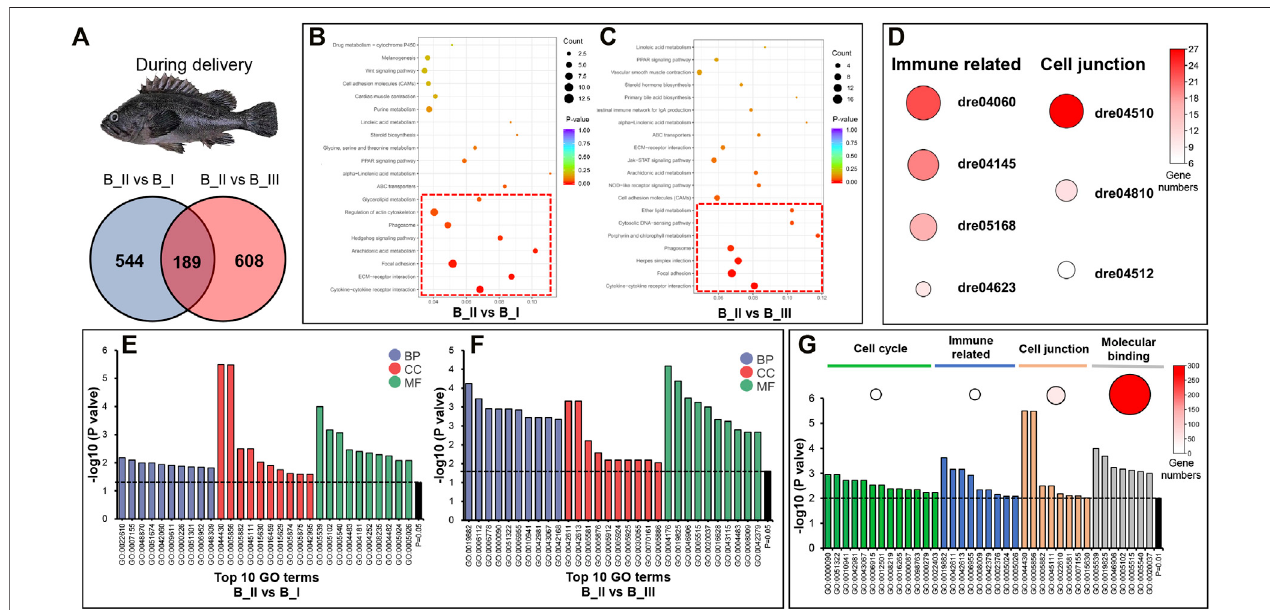
FIGURE 2 | GO and KEGG annotation of DEGs in B_II vs. B_I group and B_II vs. B_III groups. Venn diagram of DEGs in B_II vs. B_I and B_II vs. B_III (A) . Bubble chart of KEGG pathways in B_II vs. B_I (B) group and B_II vs. B_III group (C) ; red boxes indicated the signi fi cant enriched pathways ( p value < 0.05). Heatmap of immune-related and cell junction pathways in both B_II vs. B_I group and B_II vs. B_III group; the size of each circus indicated enriched gene numbers in each pathway (D) . Top 10 GO terms in three level one categories (biological process, BP; cellular component, CC; and molecular function, MF) of B_II vs. B_I group (E) and B_II vs.B_IIIgroup (F) .GOtermsrelatedtocellcycle,immunerelated,celljunction,andmolecularbindinginB_IIvs.B_IgroupandB_IIvs.B_IIIgroup;thesizeofeachcircus indicated enriched gene numbers in each GO term (G)